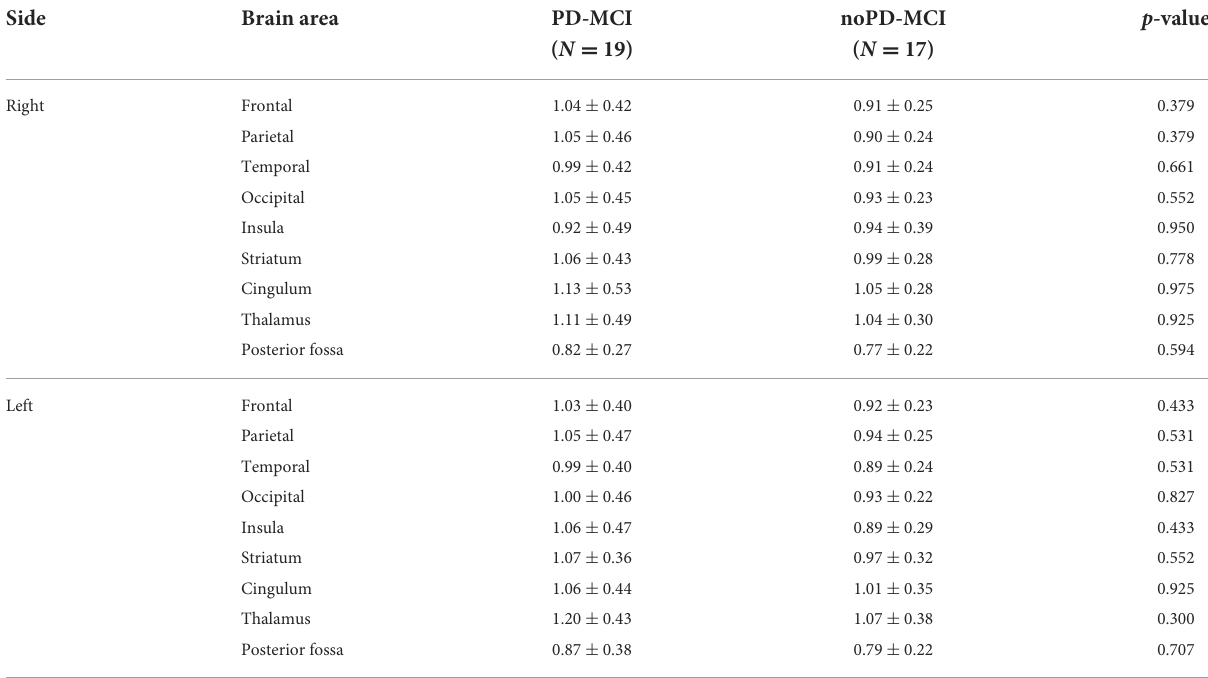
TABLE 3 Comparison of averaged SUVs evaluating amyloid PET tracer retention in brain areas in PD-MCI and noPD-MCI patients. Side Brain area